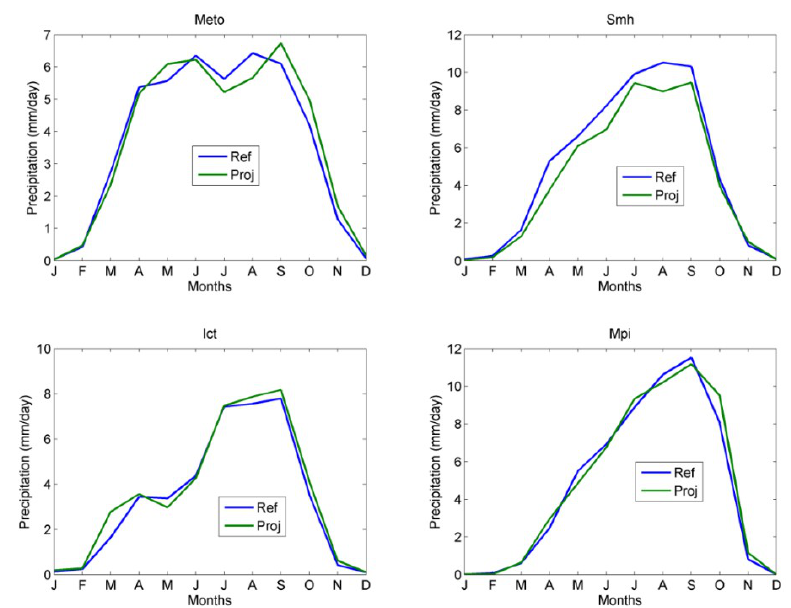
Figure 7. Regional climate models (RCMs) projection of monthly average precipitation (mm/day, 2028–2050) and comparison to the reference period (1988–2010).